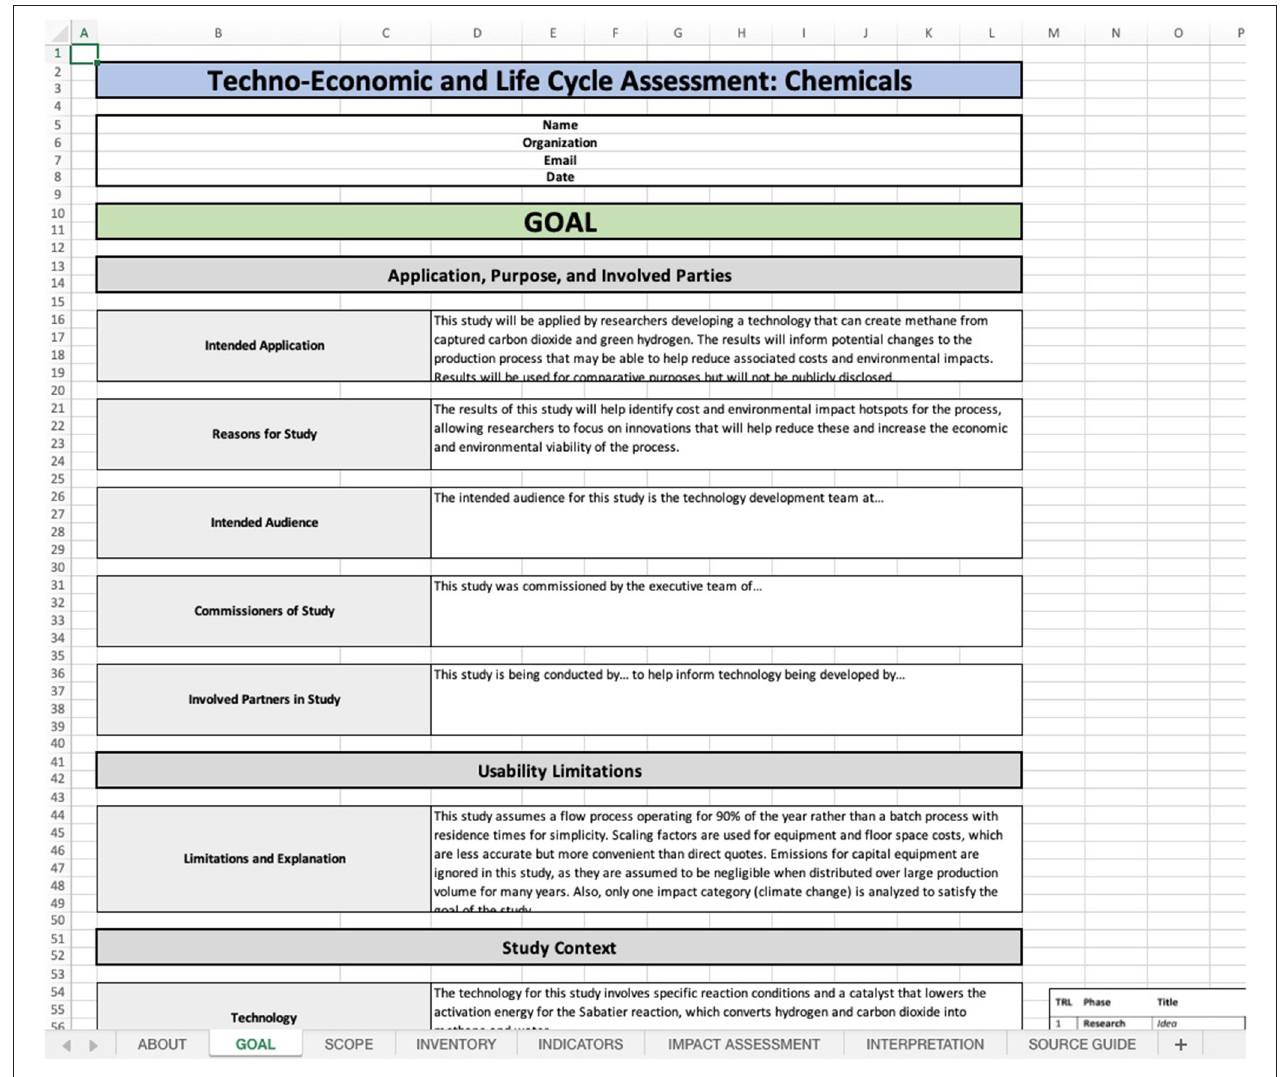
FIGURE 2 | Example worksheet demonstrating the format of the template along with worksheets on the